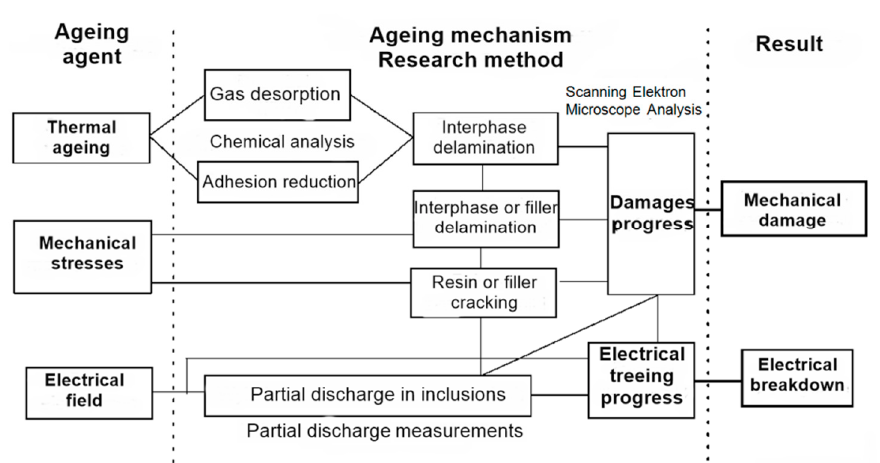
Figure 1. Schematic diagram of the generation and development of microdefects during the impact of combined exposure on composite insulation.